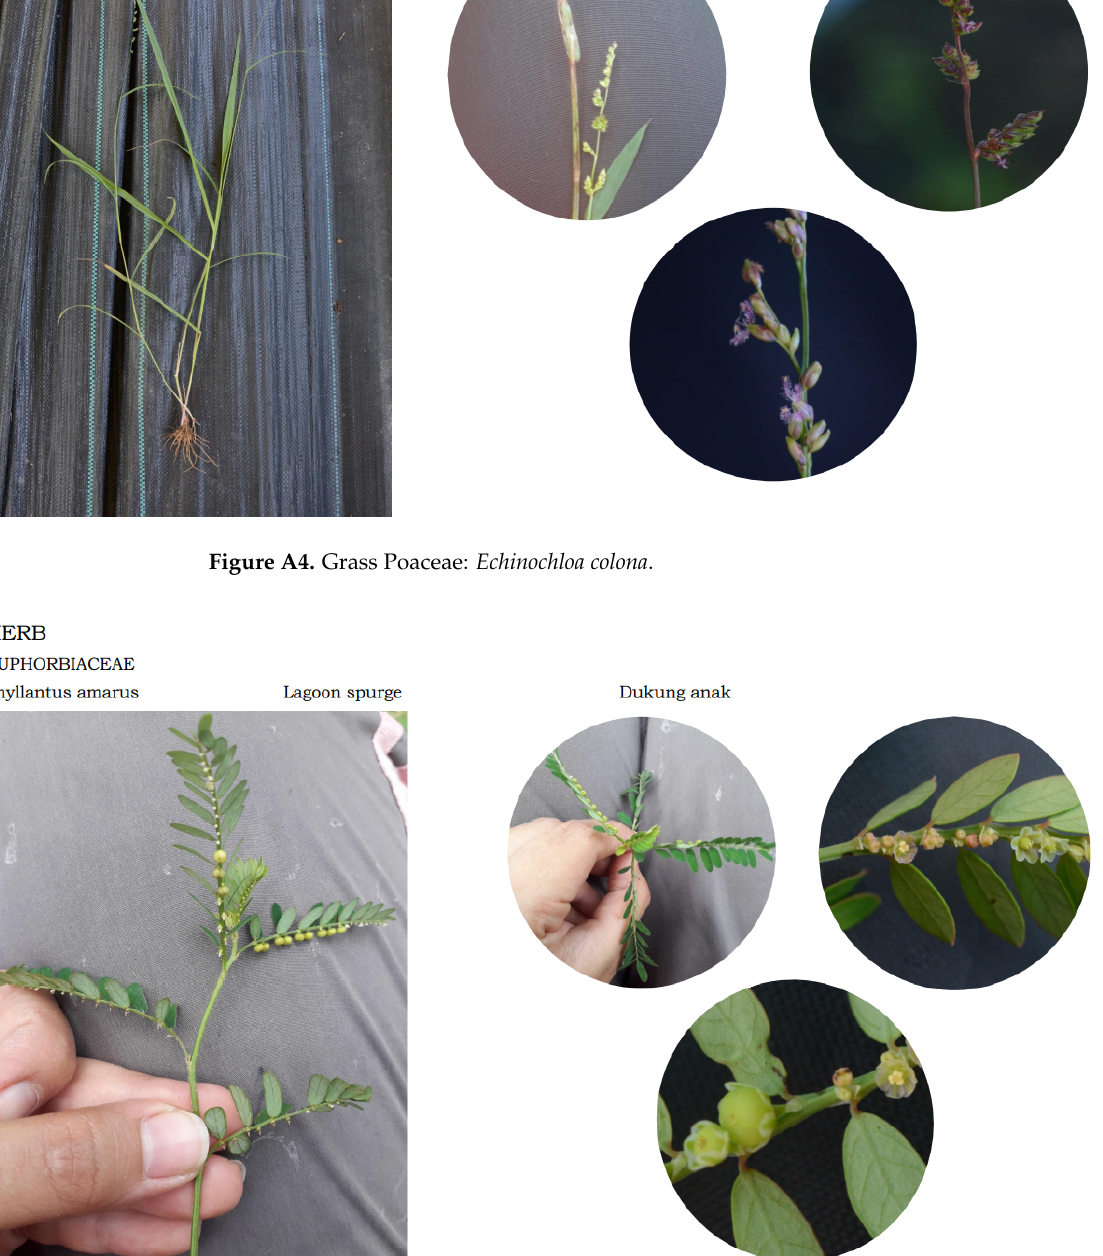
Figure A5. Herb Euphorbiaceae: Phyllantus amarus.